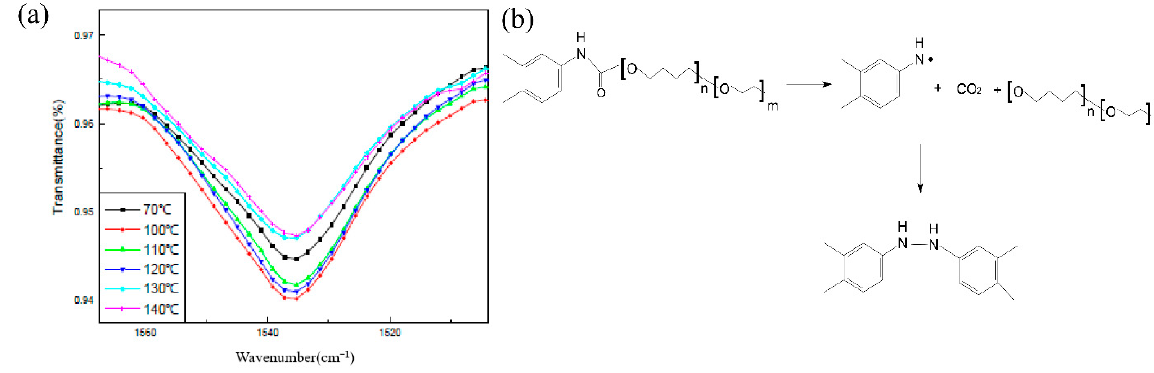
Figure 12. ( a ) Change trend of N–H relative absorbance and ( b ) decomposition reaction process.